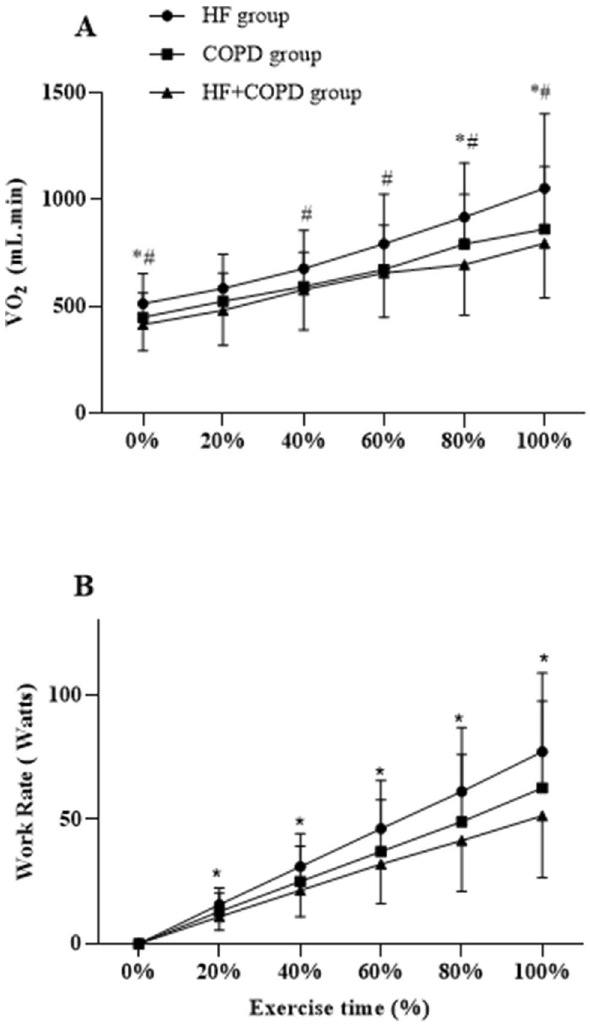
˙ V Figure 3. Behavior of O 2 and WR between groups during exercise time. *Significant difference (p < 0.05) in relation to the HF with HF + COPD. # Significant difference (p < 0.05) in relation to the HF with